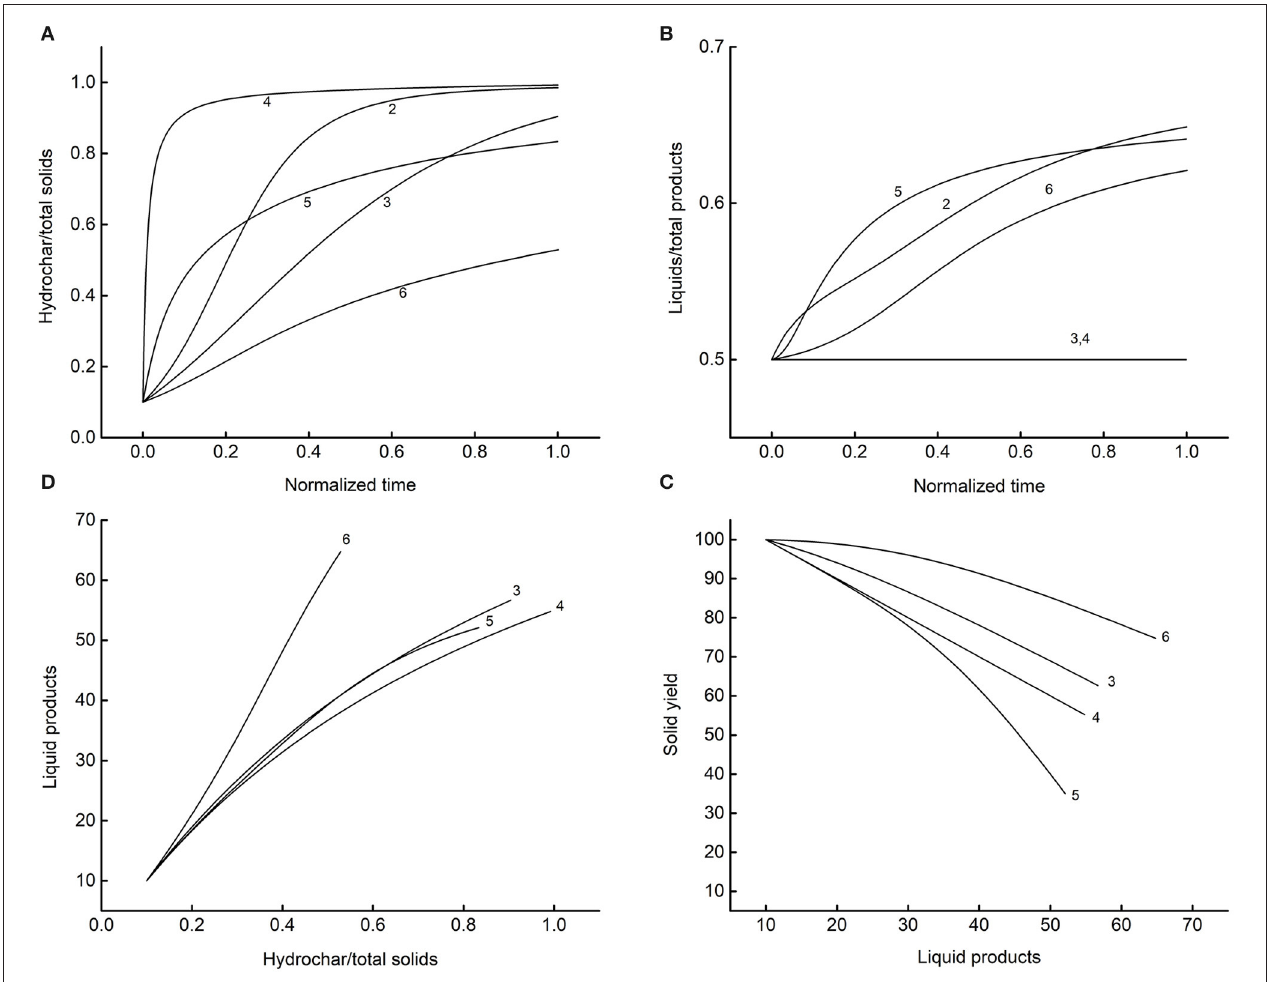
FIGURE 9 | System dynamics associated with the reaction patterns of Table 4 . The numbers next to lines label the scheme. (A) Time course of the conversion to hydrocar; (B) progression of liquid-phase moieties accumulation; (C) relationships between solid and liquid phases; (D) liquid-phase build-up as a function of solid